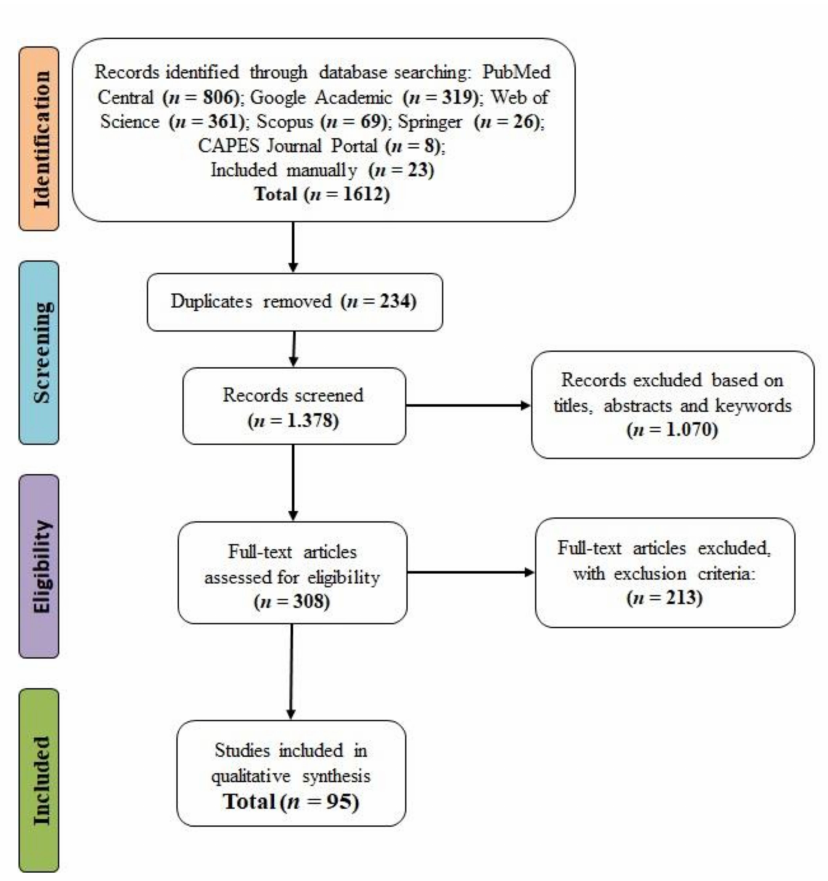
Figure 2. Flow diagram (preferred reporting items for systematic reviews and meta-analyses (PRISMA)). The selection process of studies for inclusion or exclusion in the systematic review on genetic im- provement of banana for resistance to Fusarium wilt. n = number of studies. The flow diagram was based on a model available at http://prisma-statement.org/PRISMAStatement/FlowDiagram. CAPES: Coordination for the Improvement of Higher Education Personnel (accessed on 9 December